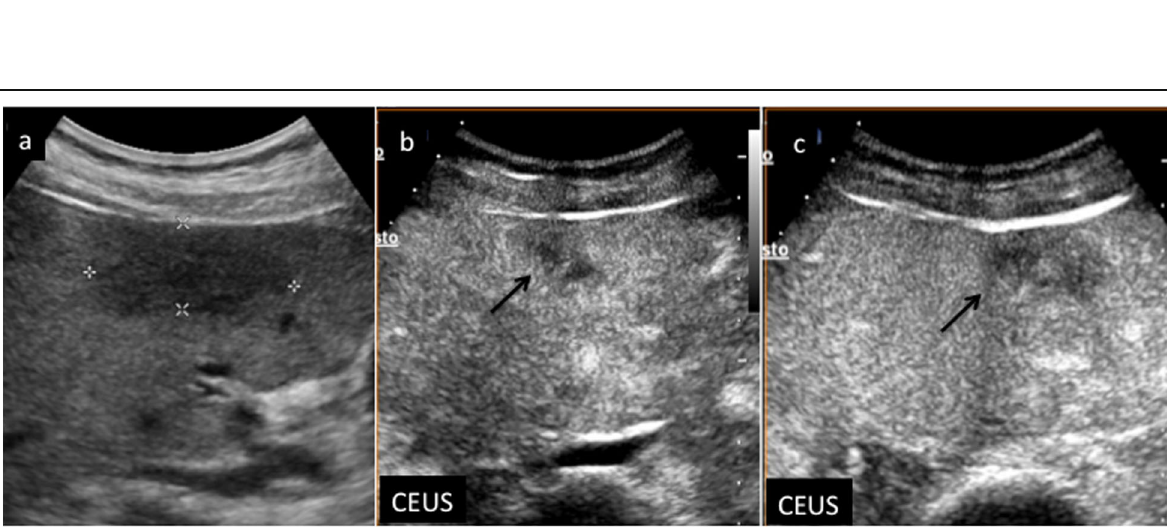
Fig. 11 CEUS LI-RADS M (probably or definitely malignant but not HCC specific) nodule. Metastasis in a 32-year-old woman with virus B-related cirrhosis. Baseline US image ( a ) shows a hypoechoic lesion with not well-defined margins sized 5 cm in the segment IV (calipers). At CEUS, the lesion is heterogeneously vascularized during the arterial phase ( b ) (arrow) showing early wash-out: 34 s after contrast medium injection ( c )